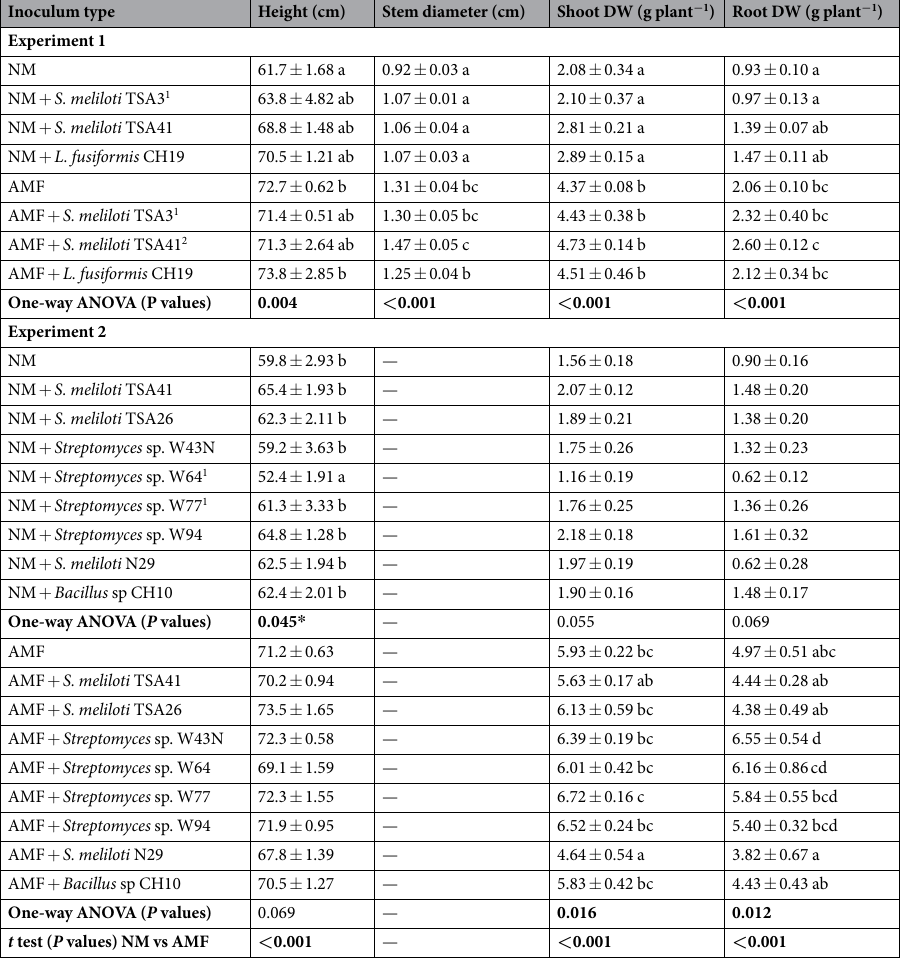
< 0.001 — < 0.001 < 0.001 Table 3. Growth responses of Zea mays L. genotype Oh43 inoculated, or not (NM), with Rhizophagus irregularis (AMF) alone or in combination with different bacterial strains. Data are presented as the mean ± s.e.m. (n = 5). Different letters indicate significantly different values ( P < 0.05). As AMF inoculation strongly increased plant variables, not allowing the satisfaction of data normality and homogeneity of variances, values of mycorrhizal and NM plants were analysed separately by one-way ANOVA, followed by Student’s t test to compare the pooled means. * Values in bold type indicate factors that had significant effects. 1 Treatment with four biological replicates; 2 Treatment with three biological